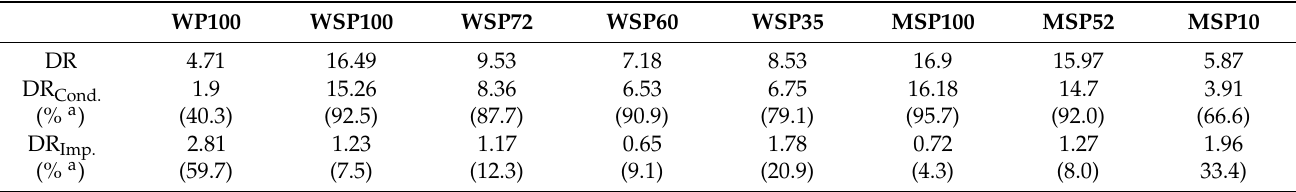
Table 8. Deposition rates (total, by condensation and by inertial impact) mean values ( λ >